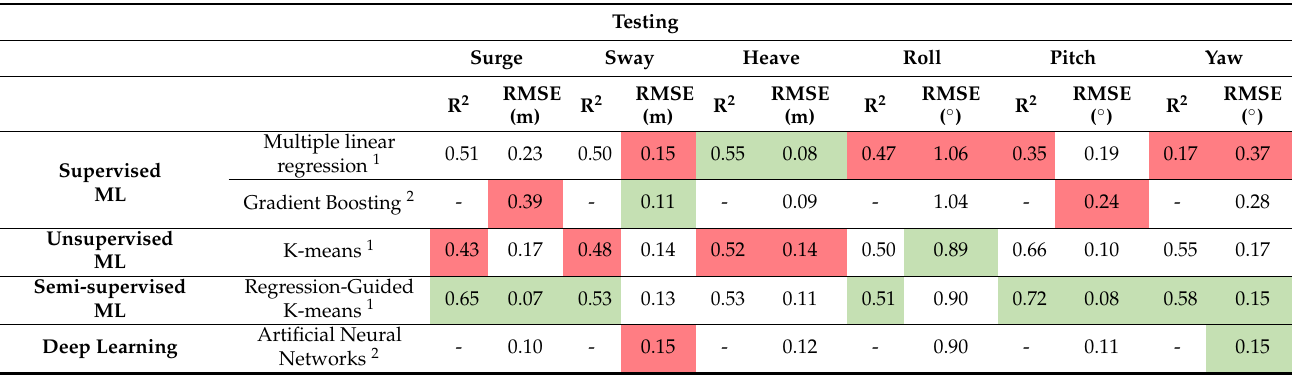
Table 5. Comparison of different ML and DL algorithms for prediction of the 6 DoF of moored ship motions. Quantification of error, RMSE; correlation, R 2 . In green, the highest values of fit, and in red, the poorest value of fit, for each case of all algorithms. Testing